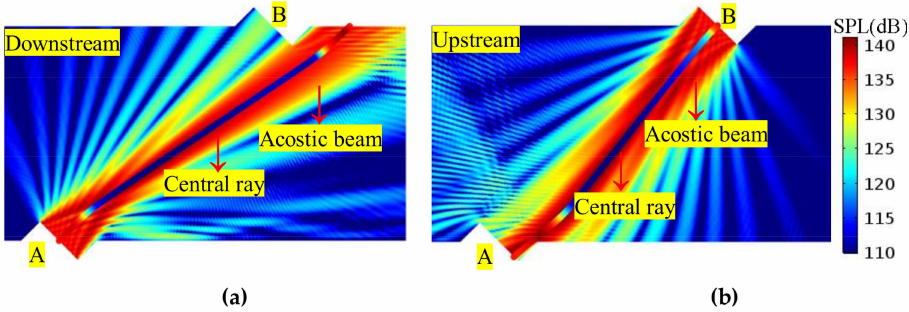
Figure 6. The central ray and the acoustic beam in the flow field ( v = 30 m/s, the PR profile). ( a ) Downstream. ( b ) Upstream.